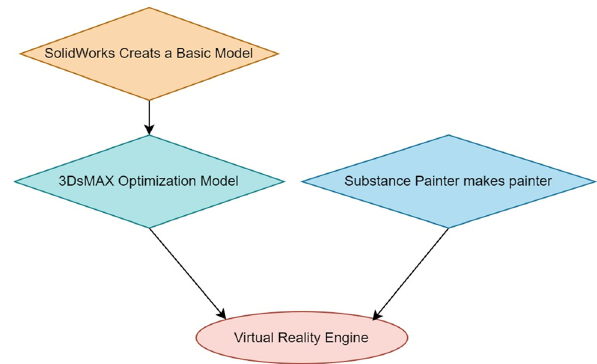
Figure 4: Model development process.